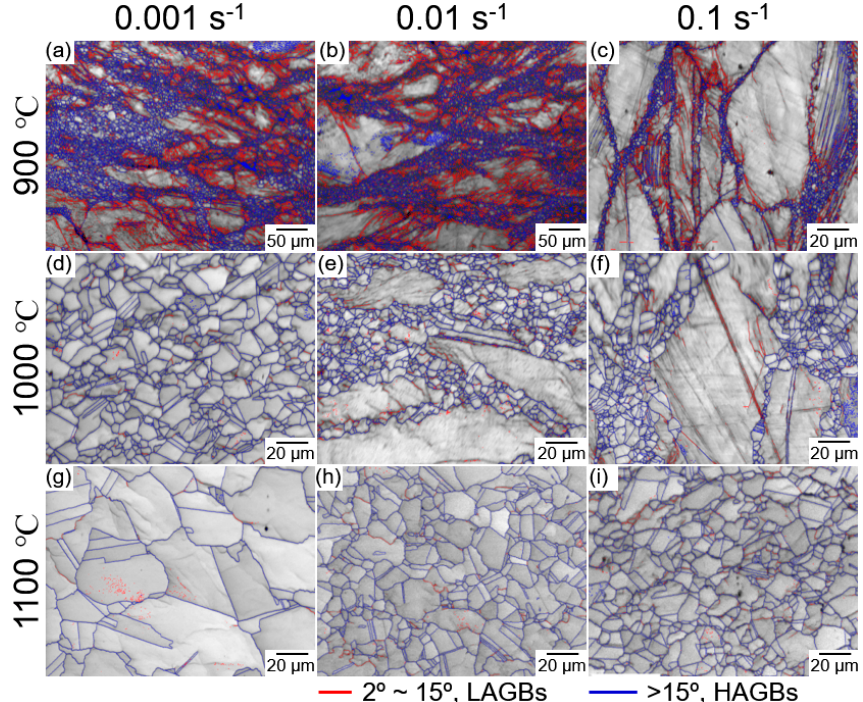
Figure 8. EBSD IQ maps of the (CoCrNi) 94 Ti 3 Al 3 alloy hot-compressed at ( a – c ) 900 ◦ C, ( d – f ) 1000 ◦ C, and ( g – i ) 1100 ◦ C with a strain rate of ( a , d , g ) 0.001 s − 1 , ( b , e , h ) 0.01 s − 1 , and ( c , f , i ) 0.1 s − 1 , respectively.